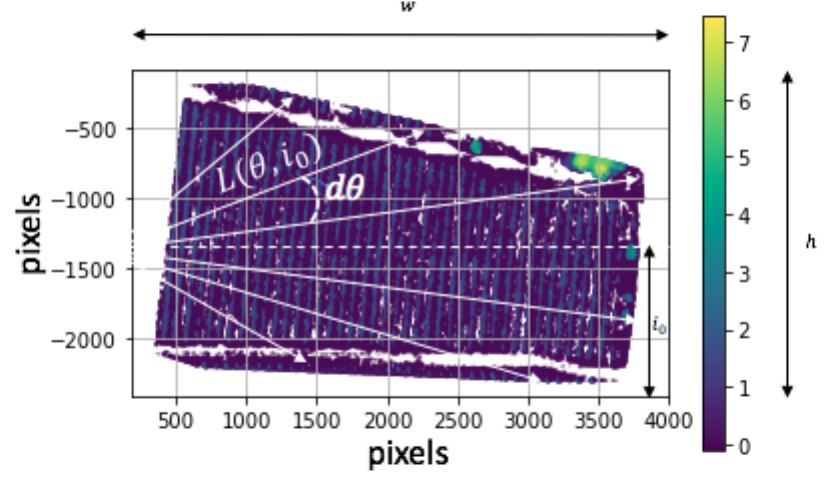
Figure 8. Geometry of the FANSCAN algorithm (see Algorithm 2). The white arrows are the raster vectors v across an extracted object field DSM. The dotted horizontal line is the current vertical scan position. Negative pixels on the z axis are an artifact of matrix to image reflection. The vertical color bar is in metres.